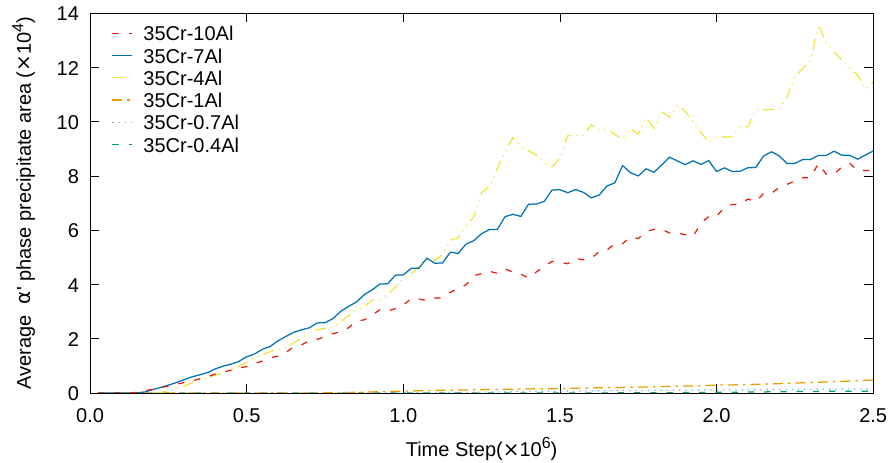
Figure 14. Average α (cid:48) precipitate volume of the 3D simulation when the average Cr concentration was 35% at various average Al concentrations.